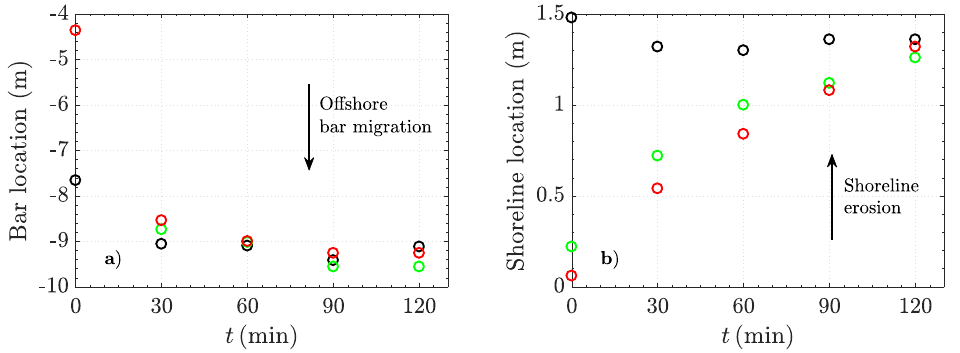
Figure 5. Bar and shoreline location during 120min of condition E2 for case1 ( ◦ ), case2 ( ◦ ) and case3 ( ◦ ). ( a ) Bar location; ( b ) Shoreline